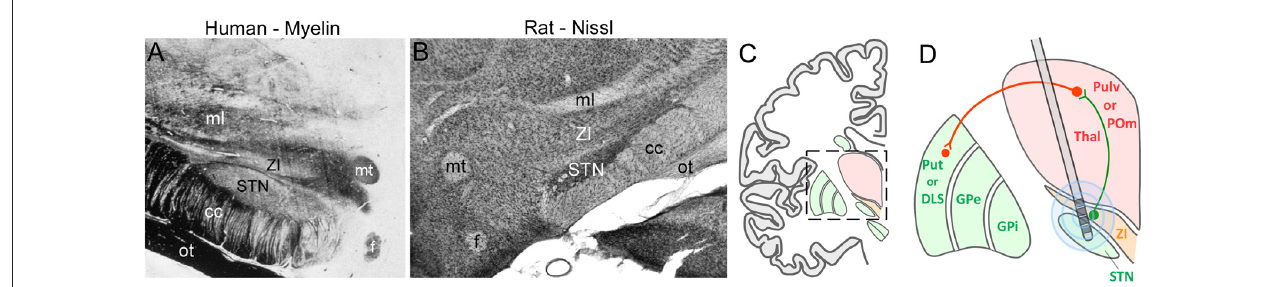
FIGURE 9 | Deep brain stimulation (DBS) in the STN can alter ZI activity. (A,B) Coronal sections from human and rat brains illustrate the close proximity of STN and ZI in myelin and Nissl-processed sections, respectively. (C) Schematic of a coronal section through the human brain shows the diencephalon with respect to the basal ganglia. Inset shows the region depicted in panel (D) . (D) Schematic showing how multiple electrode contacts combined with current spread may cause stimulation of both STN and ZI in both the primate and rodent brain. Green lines, inhibitory connections; red lines, excitatory connections. Abbreviations: GPe, globus pallidus external; GPi, globus pallidus internal; POm, posteromedial nucleus; Pulv, Pulvinar; Put, Putamen; STN, subthalamic nucleus; Thal, thalamus; ZI, zona